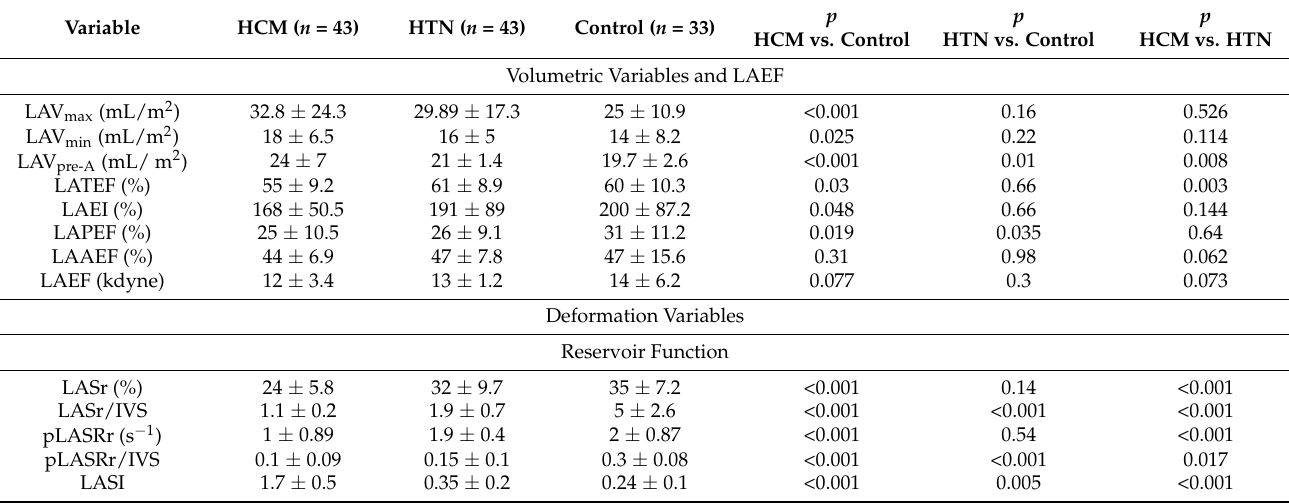
Table 2. Comparison of left-atrial (LA) volumetric and deformation parameters among patients with hypertrophic car- diomyopathy (HCM), patients with hypertension (HTN) with left-ventricular hypertrophy (LVH), and controls. Variable HCM ( n =